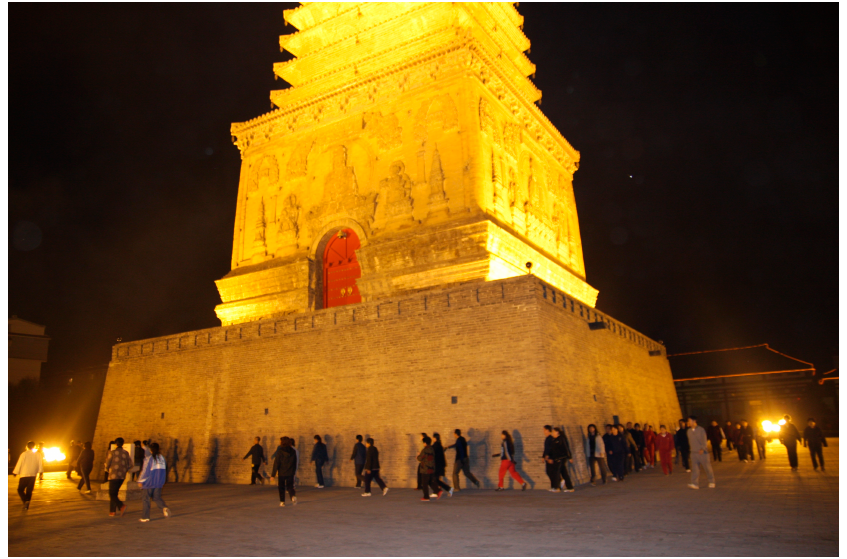
Figure 10. People circumambulating Chaoyang North Pagoda at night [©Photograph by Youn-mi Kim, 2014].